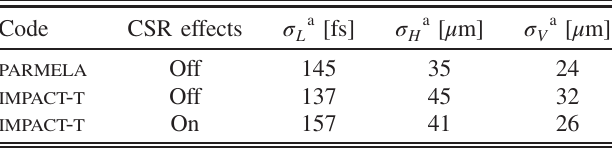
90% selected particles,